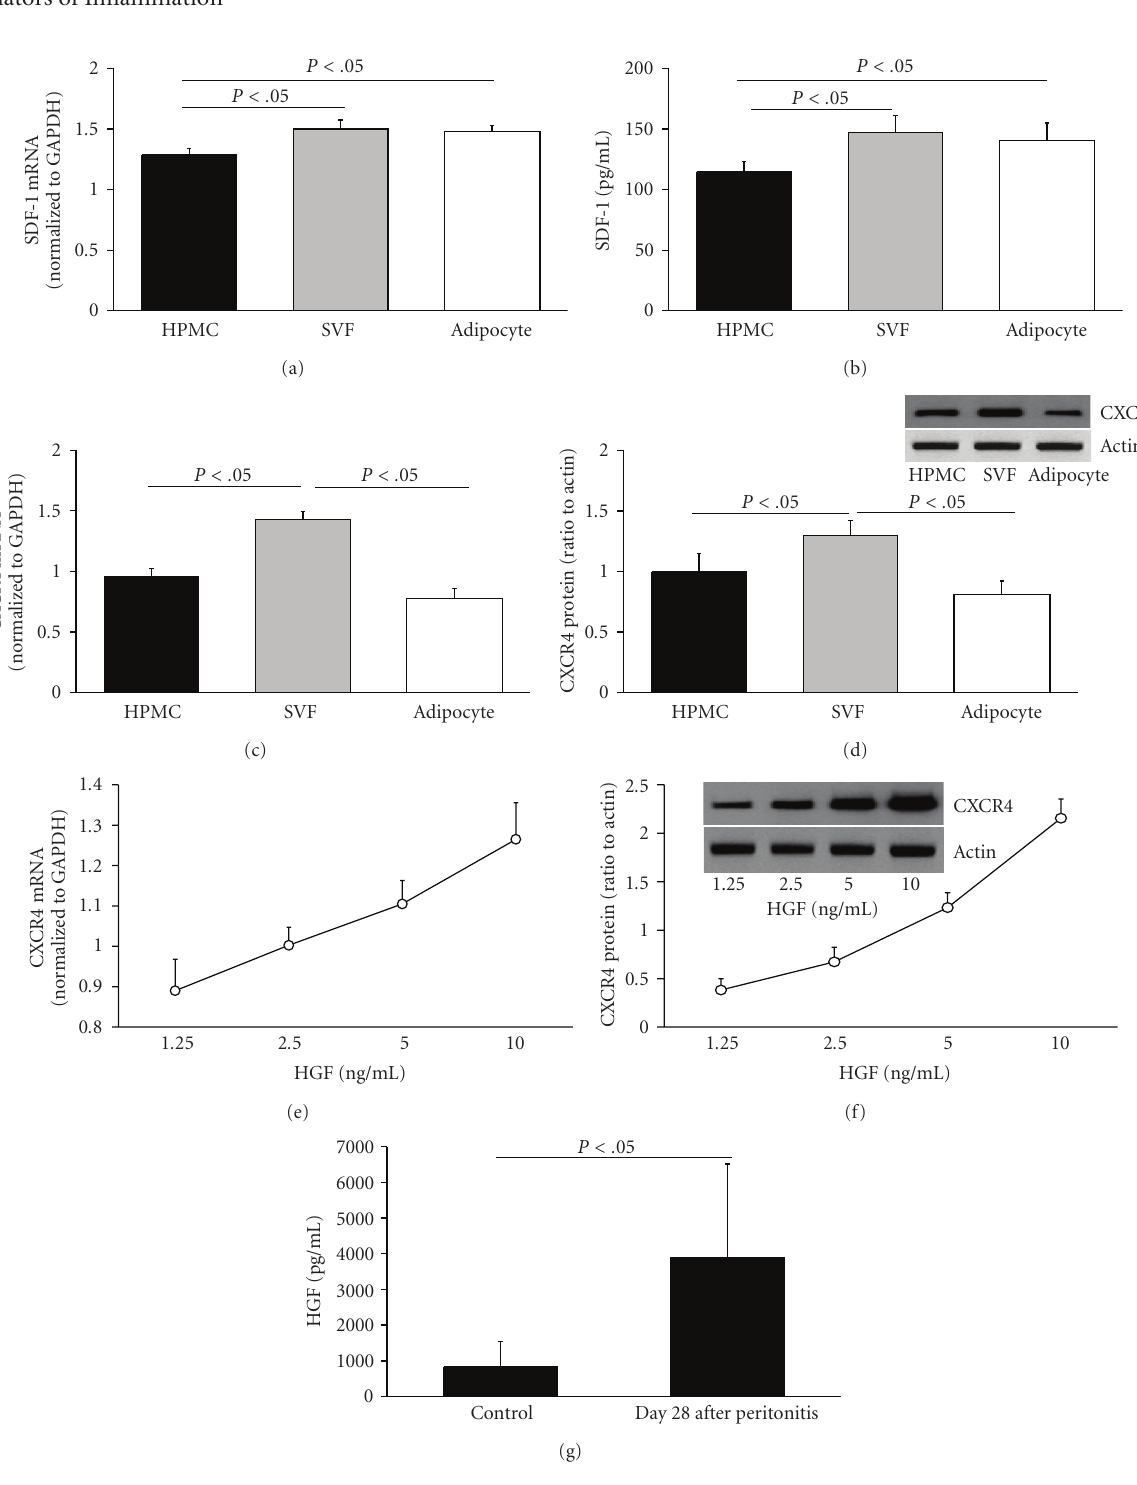
Figure 1: Constitutive expression of mRNA (expressed as amplicon ratio after normalized to GAPDH, measured by quantitative PCR), protein for G-protein-coupled chemokine receptor (CXCR4; expressed as ratio of densitometry data after normalized to GAPDH, measured by immunoblotting), and stromal derived factor-1 (SDF-1; measured by ELISA) in cultured human peritoneal mesothelial cells (HPMC), stromal vascular fraction (SVF), and adipocytes from human omental tissue (a to d). The CXCR4 expression in HPMC was up-regulated in a dose-dependent manner with hepatocyte growth factor (HGF) after 4 hours culture (e and f). Overnight PD e ffl uent fluid ( n = 15) was collected from CAPD patients on day 28 after the onset of peritonitis. Control PD e ffl uent fluid ( n = 15) was obtained in CAPD patients without previous history of peritonitis. The concentration of the HGF in PD e ffl uent fluid was measured by ELISA. Persistent release of HGF in PD e ffl uent was observed at day 28 after peritonitis in CAPD patients (g). These data are from our unpublished